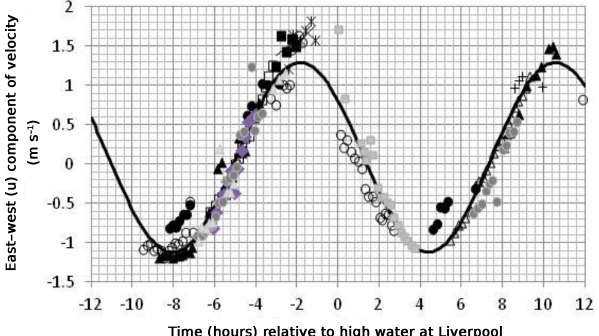
Figure 3. An example of curve fitting to bird velocity observations. The points show the east–west component of bird velocity in a box 53.5 to 53.6 ◦ N, 4.4 to 4.6 ◦ W (a different symbol is used for each bird). The continuous curve is a sine curve of period 12.42h fitted to the